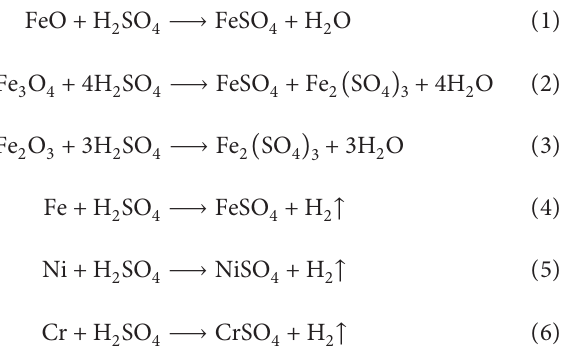
2 SO 4 solutions at